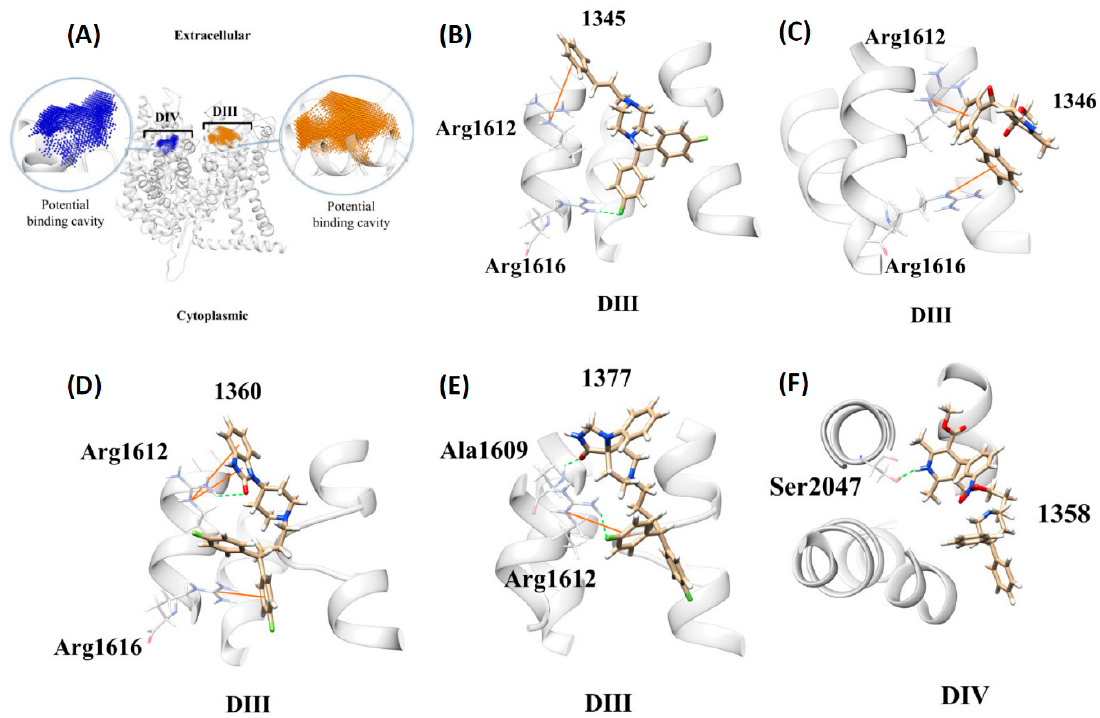
Figure 4. The molecular docking poses of compounds 1345, 1346, 1358, 1360 and 1377 based on the homology modeling with Danio rerio Cav1.2 protein sequence. ( A ) The two located cavities in domain III (DIII) and IV (DIV) of the modeling Cav1.2 are colored blue and orange, respectively. The best docking poses for compounds 1345 (Flunarizine hydrochloride, B ), 1346 (FPL-64176, C ), 1360 (Pimozide, D ), and 1377 (Fluspirilene, E ) are in the DIII cavity. However, the best pose for compound 1358 (Niguldipine-HCl, F ) is in the DIV cavity. Note that the hydrogen bonds are represented in green dotted lines while π -cation interactions are in orange lines. The carbon atoms of proteins are colored white. The carbon atoms of the best docking poses are colored tan.